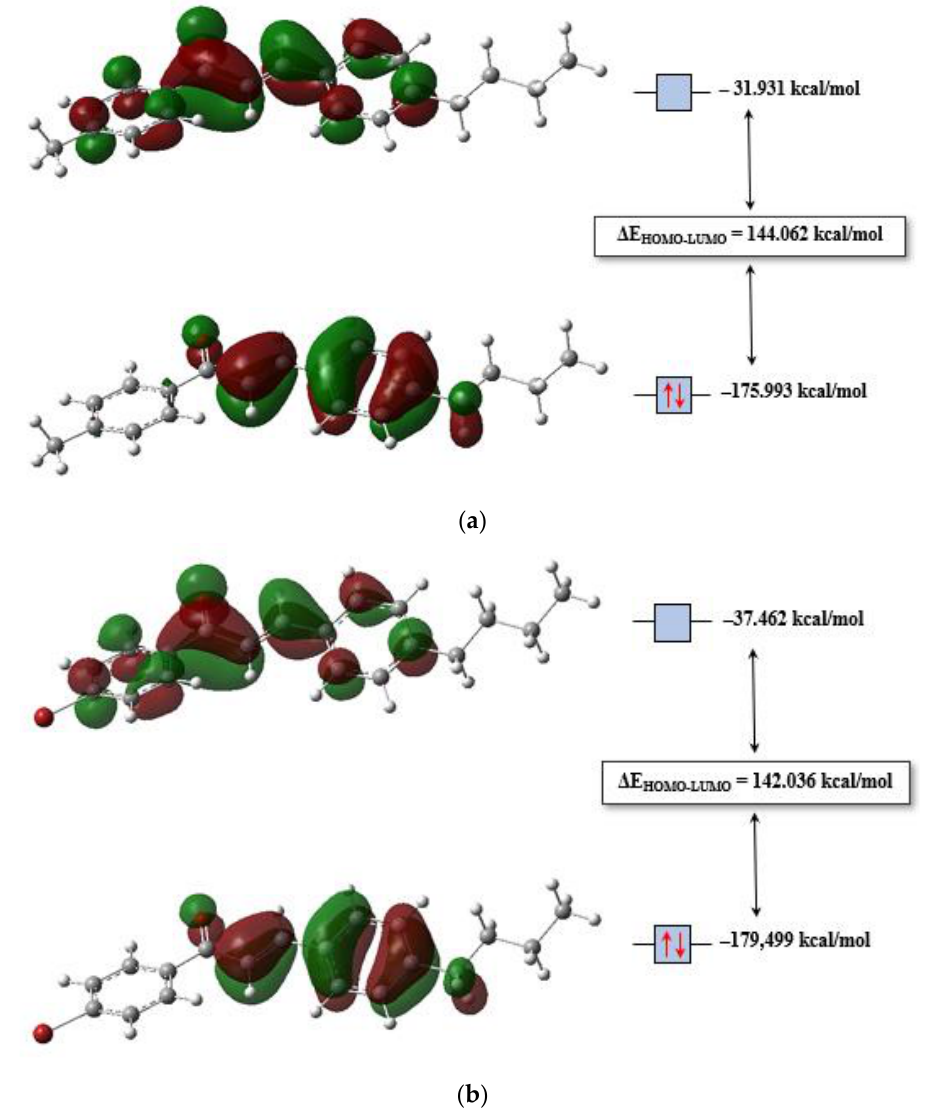
Figure 5. HOMO and LUMO plots for ( a ) BMP and ( b ) BBP obtained at M06-2X/6-311++G(d,p) level of theory. Table 2. Reactivity indices for BMP and BBP chalcones, obtained at M06-2X/6-311++G(d,p) level of